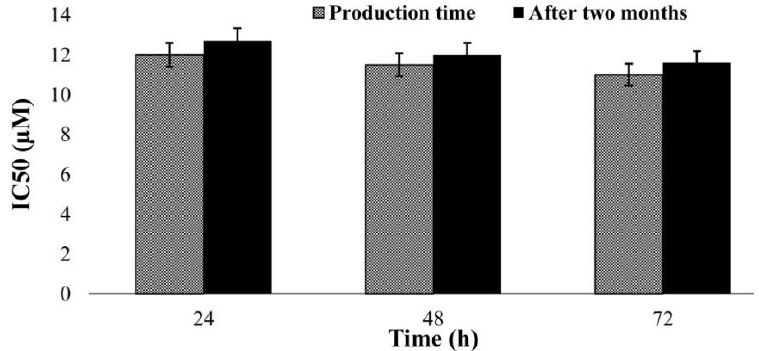
Figure 4. The cytotoxicity effects (IC 50 ) of cisplatin-loaded PBCA NPs (A4; 1.0% w / v PEG concentration, 65 °C) on the LLC1 cell line in the first day after production and two months later. The results are presented as mean ± 5% values from three independent tests.